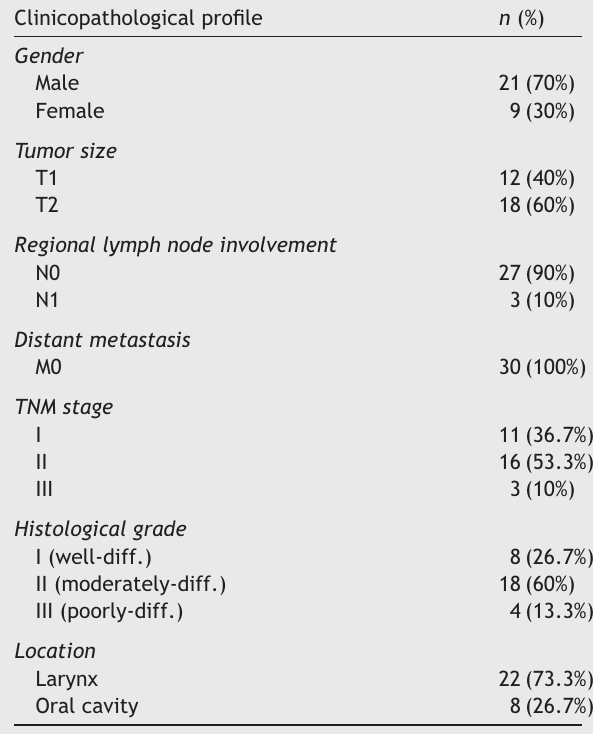
Clinicopathological profile of 30 head and neck squamous cell carcinoma